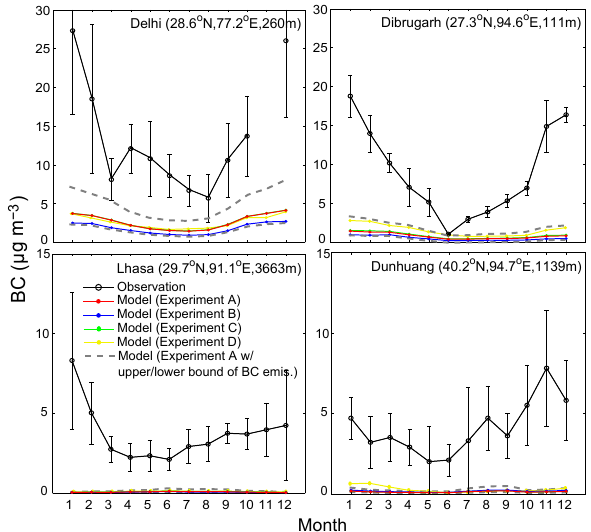
Figure 3. Same as Fig. 2, but for four urban sites (see Table 1 and Fig.